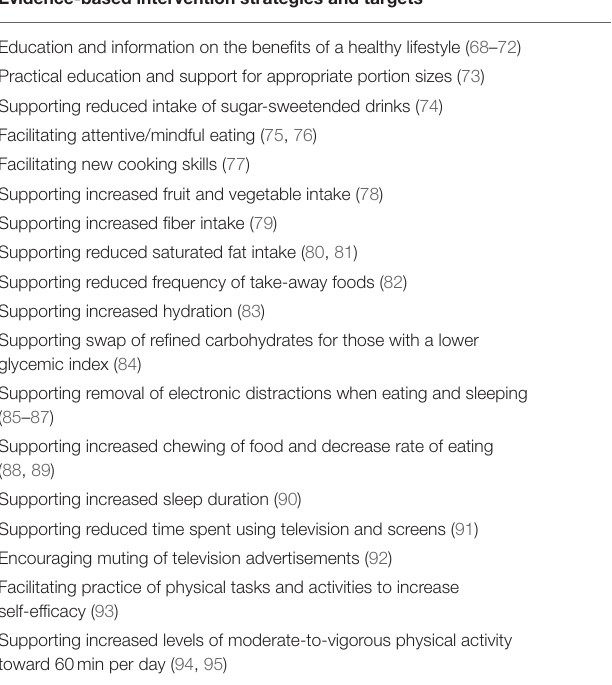
TABLE 1 | Example components included in complex intervention for obesity treatment. Evidence-based intervention strategies and